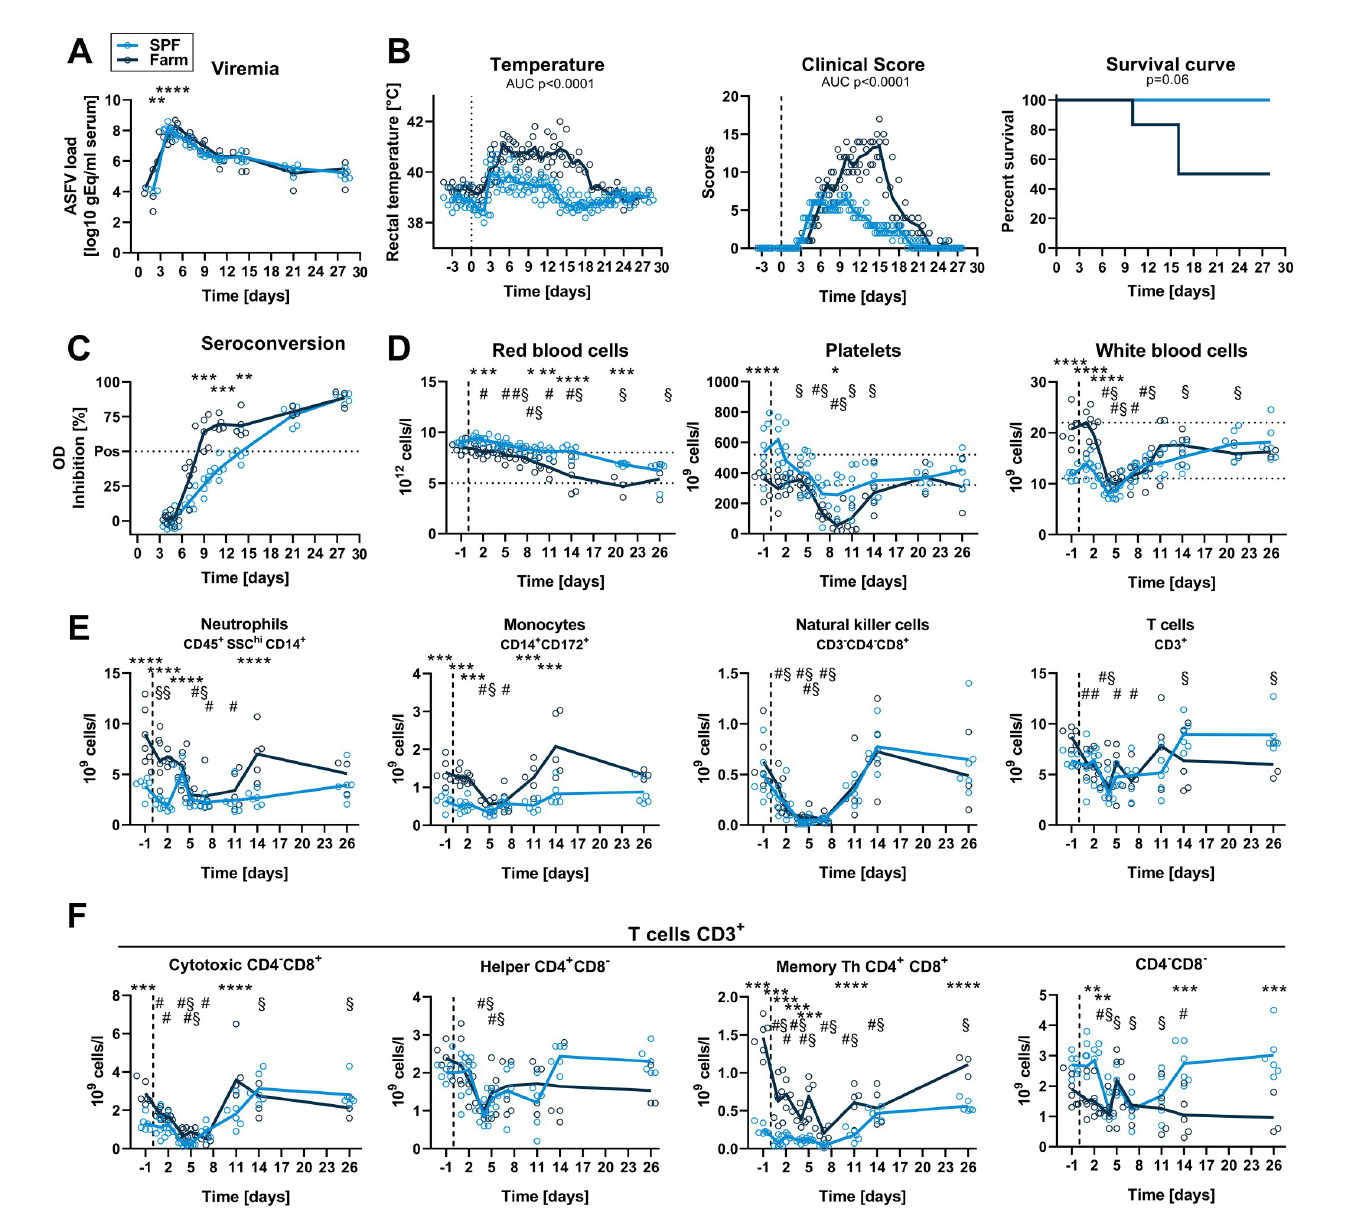
Fig 7. Virus load, clinical signs, and blood cell profiles after infection with attenuated ASFV strain Estonia 2014. SPF and farm pigs were inoculated intramuscularly with ASFV Estonia 2014 and blood samples were taken 1 day before infection and 1, 2, 4, 5, 7, 11, 14 and 26 dpi. All surviving animals were euthanized on 28 dpi. (A) Viremia was determined in serum by qPCR. (B) Rectal temperature, clinical score, and survival were reported daily. (C) Seroconversion was tested by ELISA. (D) RBC, PLT, and WBC counts in blood at indicated dpi. (E) Immunophenotyping of blood leukocytes (CD45 + ). Percentage of each subset was determined by flow cytometry gating (S2 Fig) and absolute numbers were calculated using WBC counts. (F) T cell subsets were gated from CD3 + T cells. (A-F) Data points represent values for individual pigs, lines indicate the mean of each group. Data are from a single experiment (n = 6 pigs/group, except from 11 dpi (n = 5) and from 15 dpi (n = 3) for farm group). (A, C-F) Differences between SPF and farm groups were analyzed by unpaired t test at each dpi with Holm-Sidak’s correction for multiple comparisons. � p < 0.05; �� p < 0.01; ��� p < 0.001; ���� p < 0.0001. (B) Differences between groups for body temperature and clinical scores were analyzed by comparing the area under the curve (AUC). Differences in survival were analyzed by Log-rank (Mantel-Cox) analysis. (D, F) Significant differences in blood cell subsets at different dpi compared to the respective baseline (-1 dpi) are indicated for SPF (§, p < 0.05) and farm (#, p < 0.05); data were analyzed using mixed model analysis followed by Dunnett’s multiple